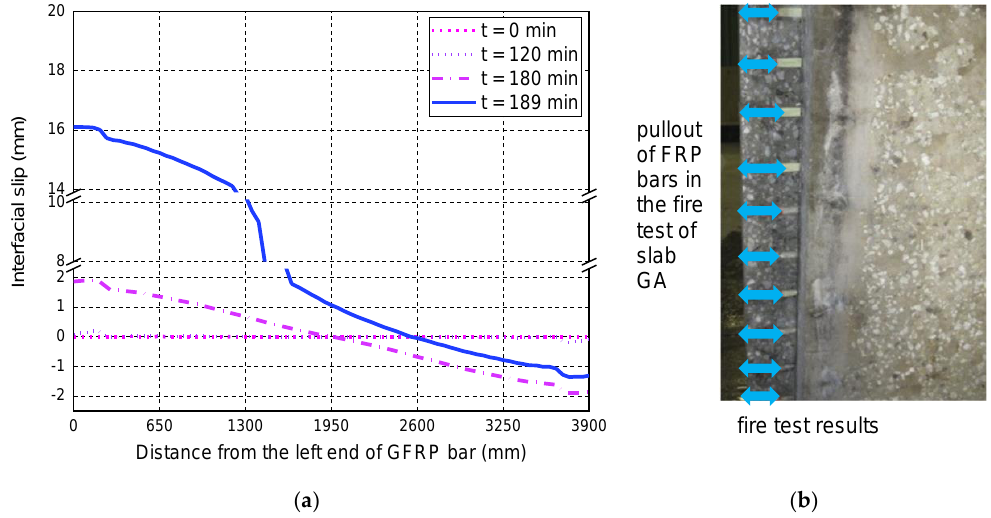
Figure 8. Interfacial slip distributions along the length of the GFRP bar: ( a ) FE predictions; ( b ) the observed pullout failure mode of GFRP bars.